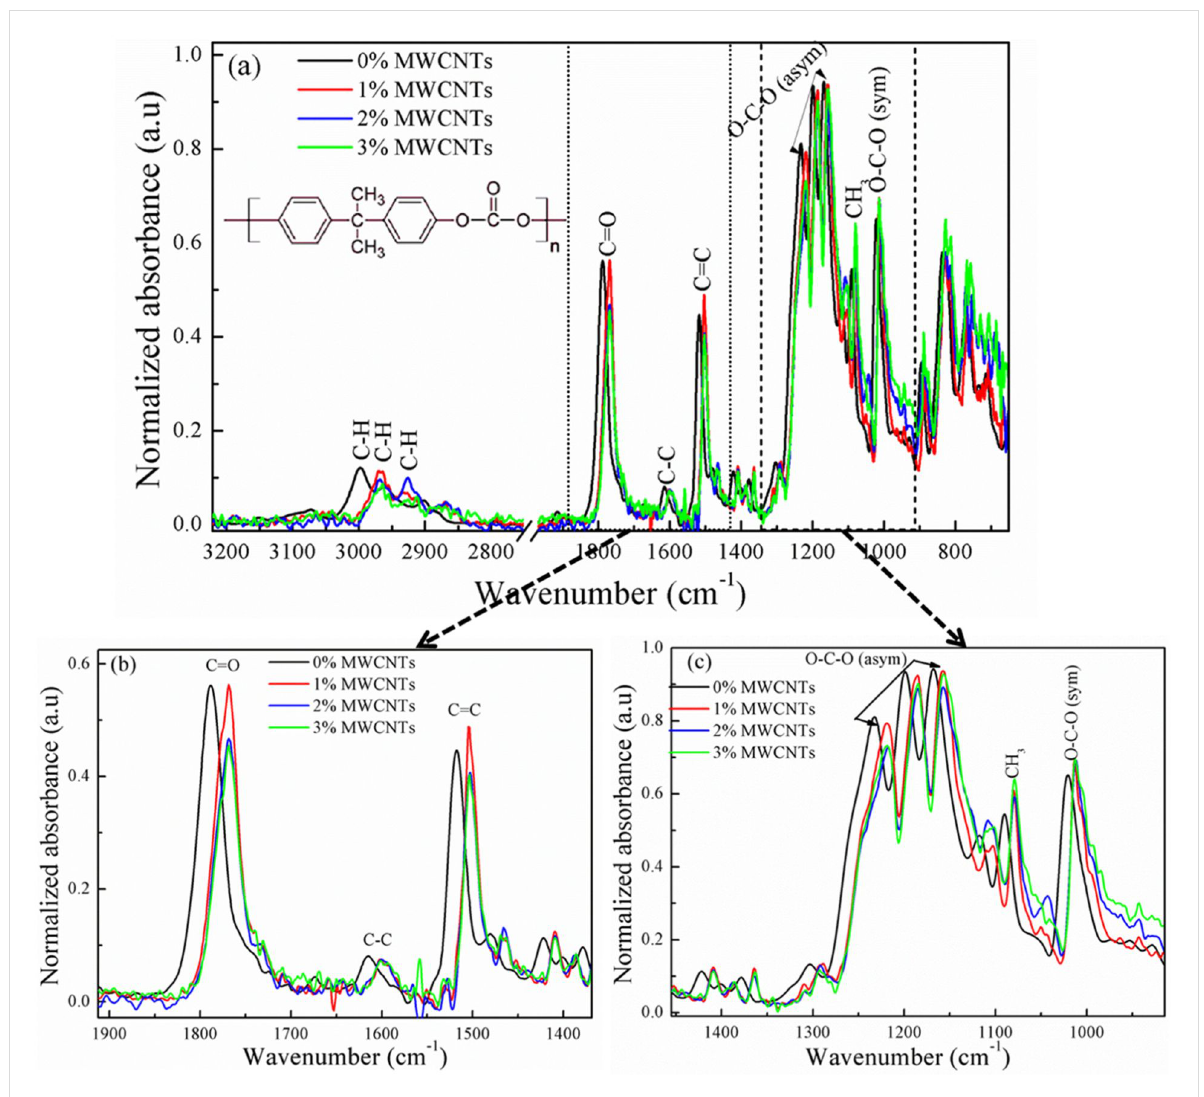
Figure 3: a) FTIR absorption spectrum of the PC/MWCNT composite films at different loadings (inset: structure of PC). Zoomed area in the b) carbonyl and c) ester group spectral